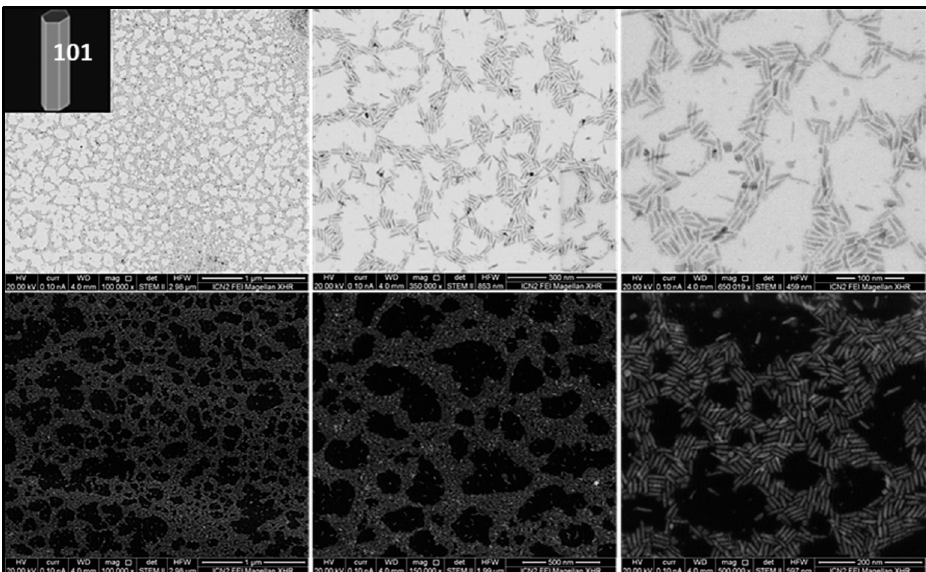
Figure 2. TiO 2 rods. STEM images of TiO 2 NPs synthesized using TTIP as precursor in the presence of OLAM. In the presence of the co-surfactant OLAM, pure phase brookite rods (50 nm side length, 15 nm width) are formed using TiCl 4 as precursor.